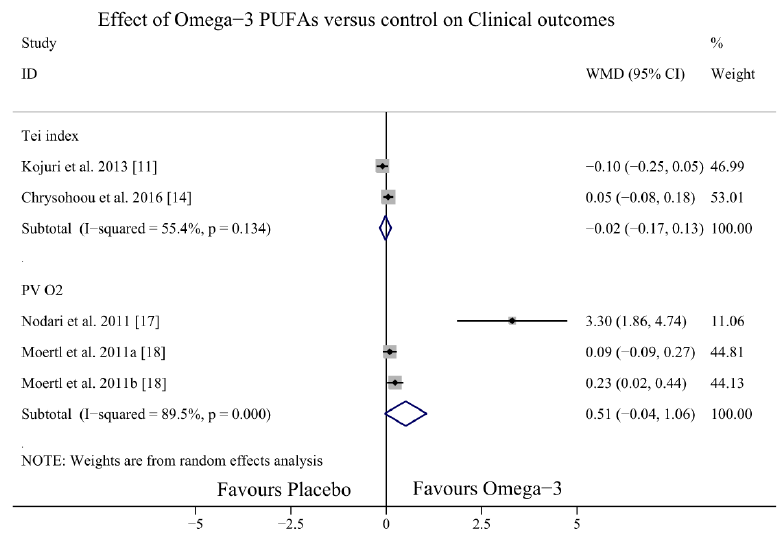
Figure 10. Forest plot depicting the effect of omega-3 PUFAs on Tei index and peak VO 2 (WMD, weighted mean difference). Abbreviation: PUFAs, polyunsaturated fatty acids; peak VO 2 , peak oxygen consumption.